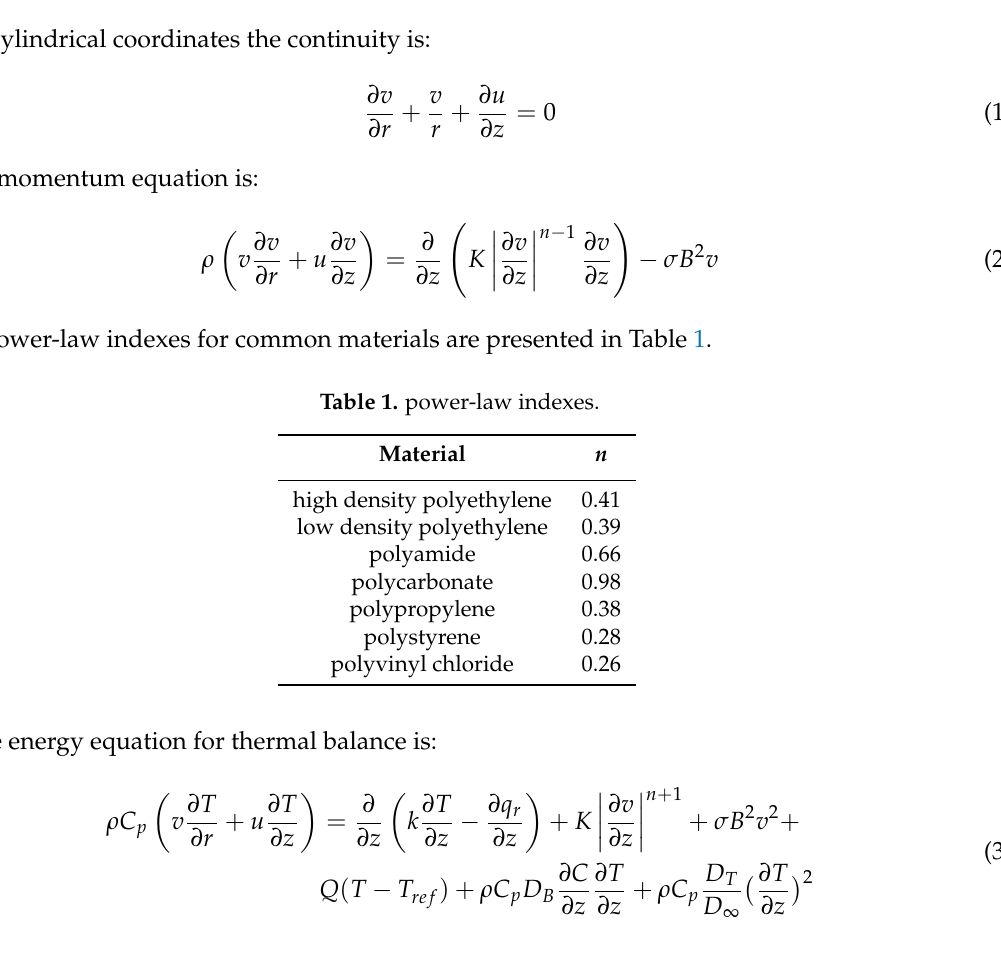
Figure 1. Schematic representation of the considered problem.